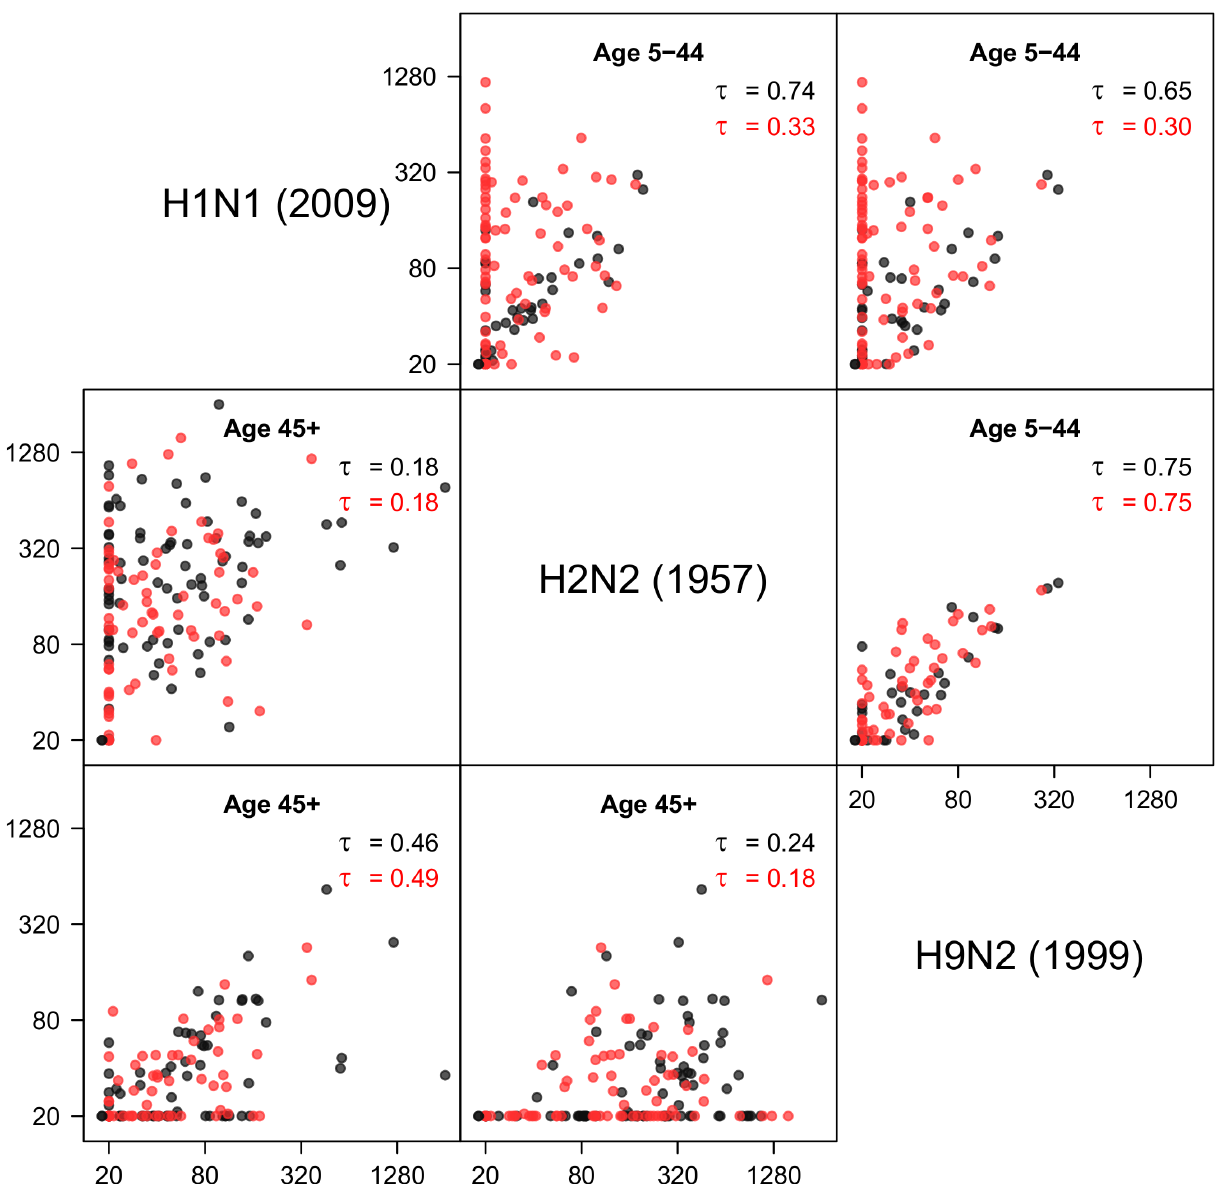
Fig 2. Correlations of antibody responses to group 1 influenza viruses. Results are given for age groups 5-44 years (abovethe diagonal)and 45+ years (belowthe diagonal).Black dots: pre-pandemic survey; red dots: post-pandemic survey. In each panel, Kendall’stau is given for the pre- and post-pandemics surveys (black and red). Notice the strong positive correlationbetweenH2N2 and H9N2 antibody titers in personsup to 45 years, i.e. personswho are unlikelyto have experienceda natural H2N2infection. Positive antibodytiters to H2N2 and H9N2 are found almost exclusively in personswith positive A/2009 (H1N1) response, suggestingthat A/2009 (H1N1) infection yields a responsethat is cross-reactive with both H2N2 and H9N2.